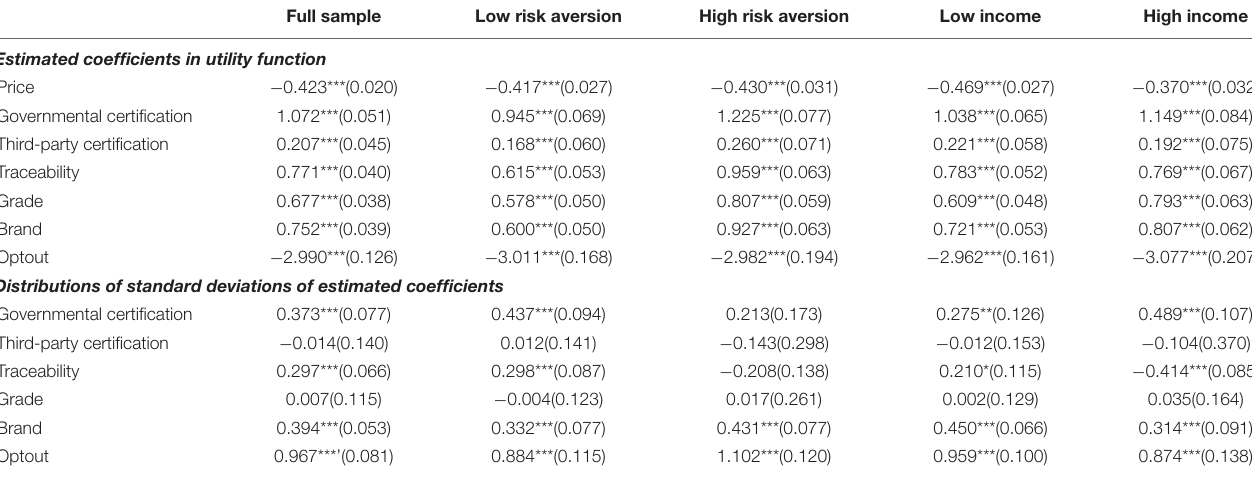
TABLE 3 | Results of the mixed logit model.